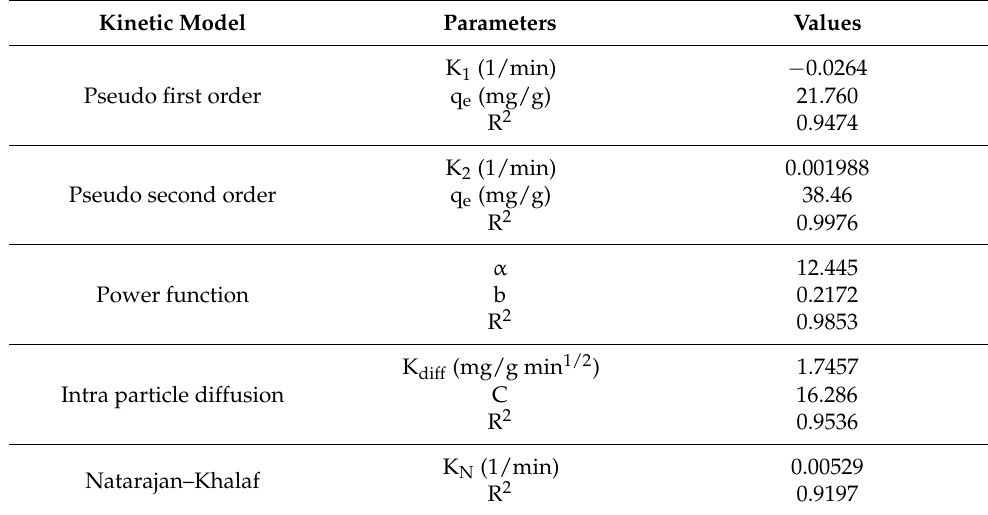
Table 3. Kinetic parameters of Zn (II) biosorption on CMPVL.